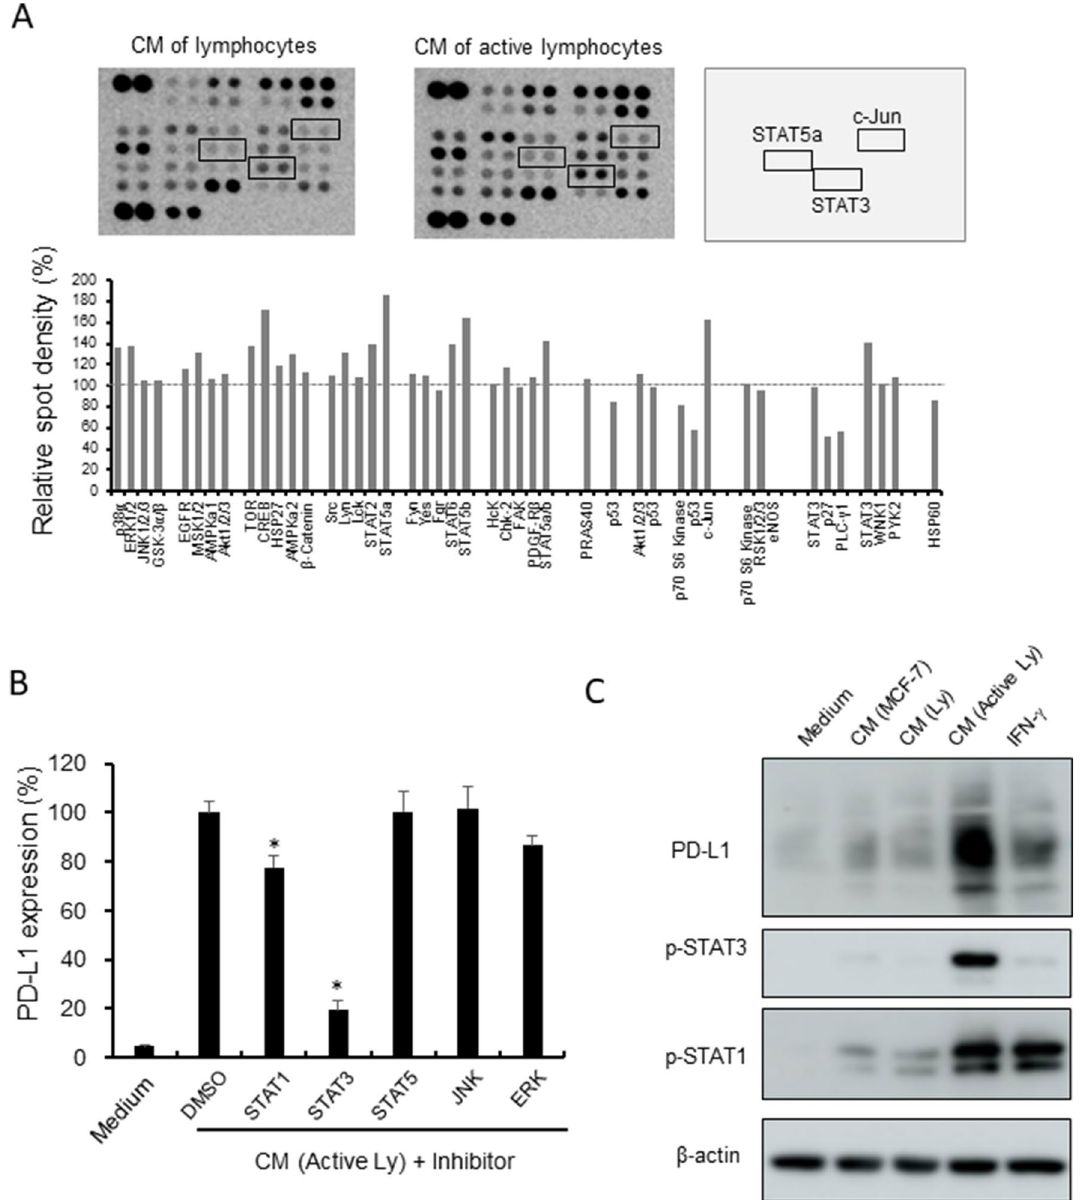
Figure 2. STAT1 and STAT3 activation in macrophages. ( A ) A phosphorylation kinase array was performed using HMDMs stimulated with the CM of resting lymphocytes and activated lymphocytes. Spot densities were STAT5, JNK, and ERK (10 nM) for 24 h, and PD-L1 expression was examined by a cell-ELISA assay ( n = 3 to 5 each). (C) Western blot analysis of PD-L1, pSTAT1, pSTAT3, and β-actin was performed using the lysates